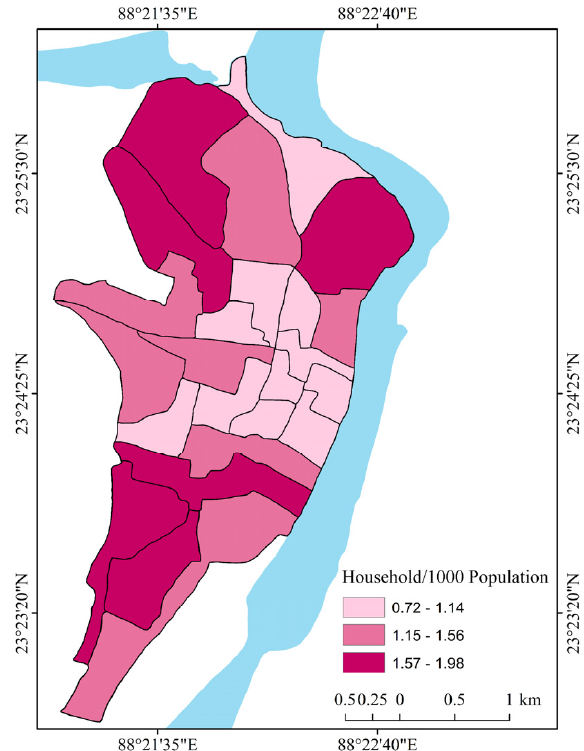
Figure 55. Ward ‐ wise distribution of households/1000 population in Nabadwip Municipality (2011).